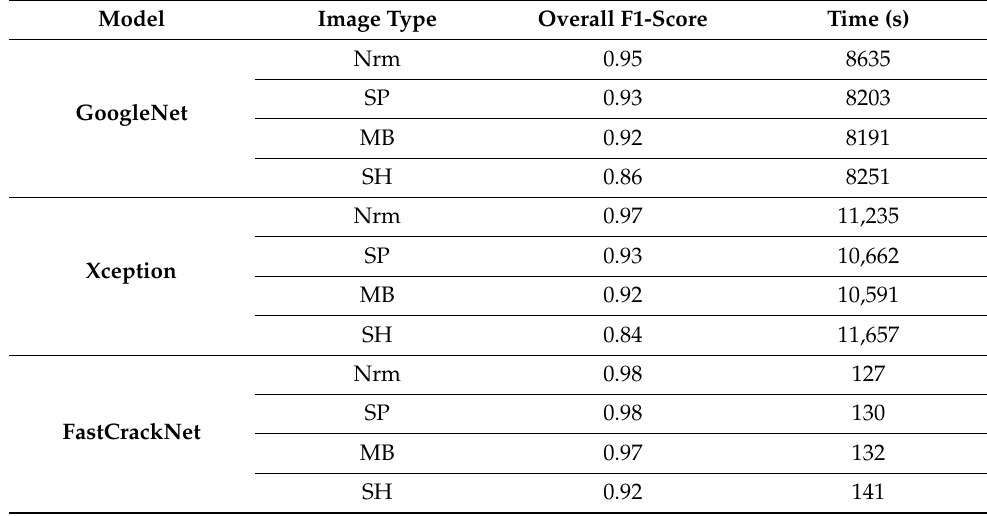
Table 3. Comparison of